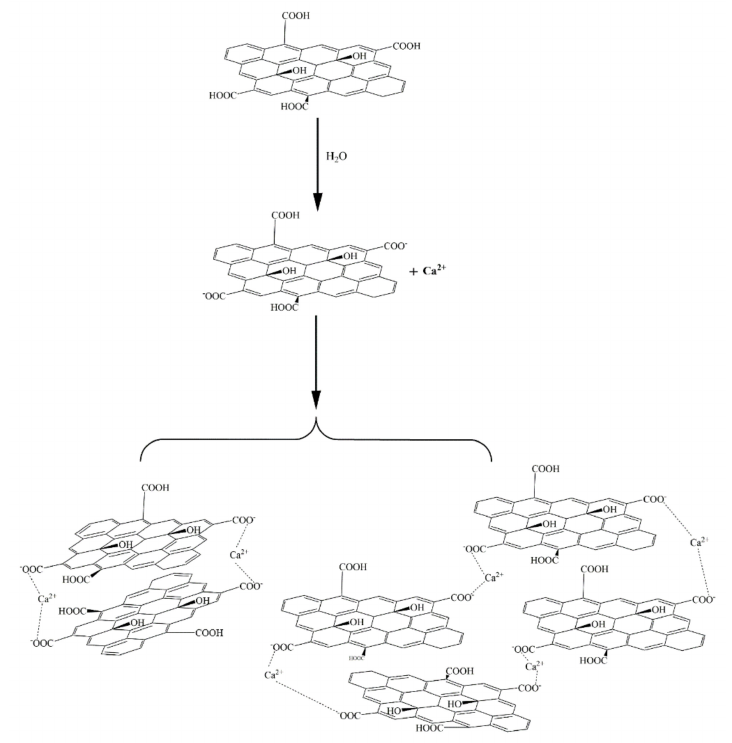
Figure 20. Formation of GO aggregates in Ca 2+